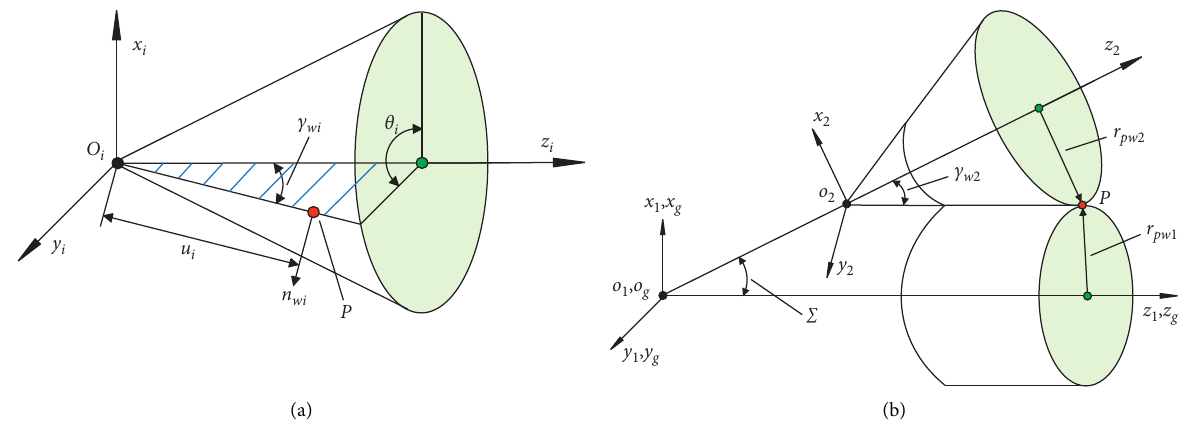
Figure 2: Beveloid gear work pitch cone model. (a) Work pitch cone. (b) Gear meshing coordinate